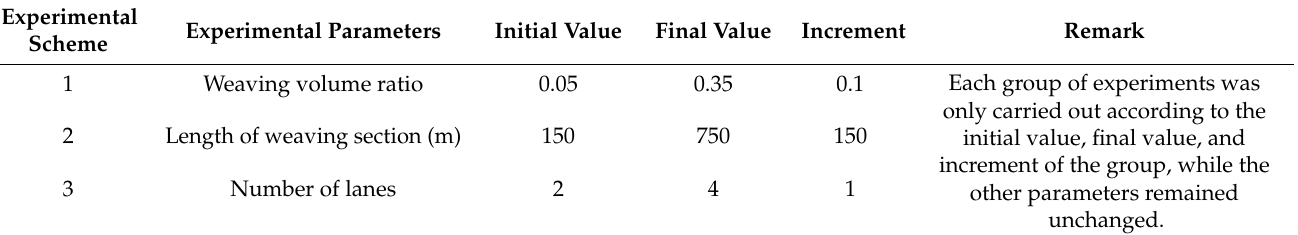
Table 3. Summary of experimental